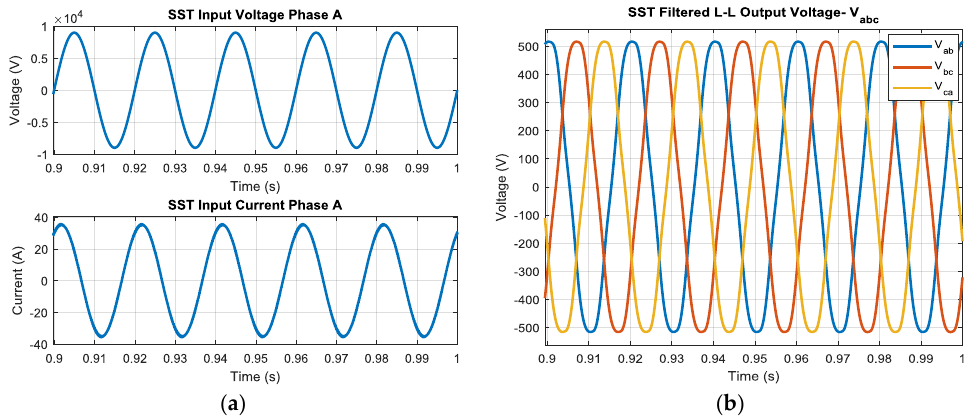
Figure 23. SST simulation results as the power factor improvement (PFI) device. ( a ) The input current leads the input voltage. ( b ) SST filtered output voltage.